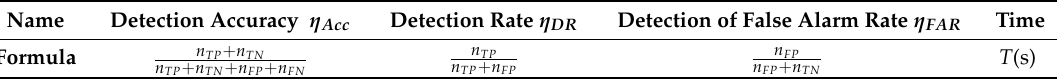
Table 1. Evaluation criteria calculation about different detection algorithms.